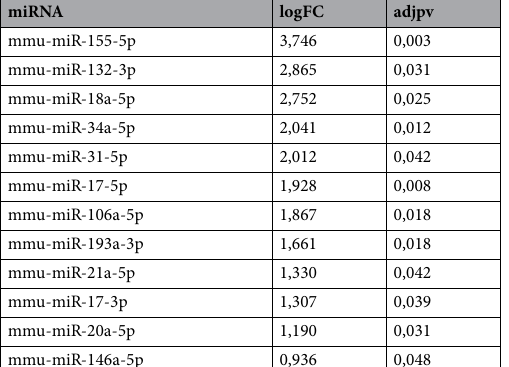
miRNA logFC adjpv mmu-miR-155-5p